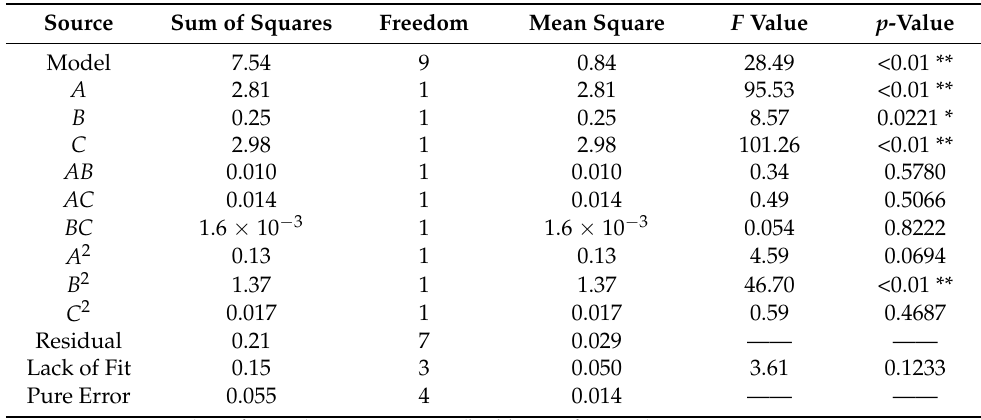
Table 7. Variance analysis of quadratic term model of tillage depth